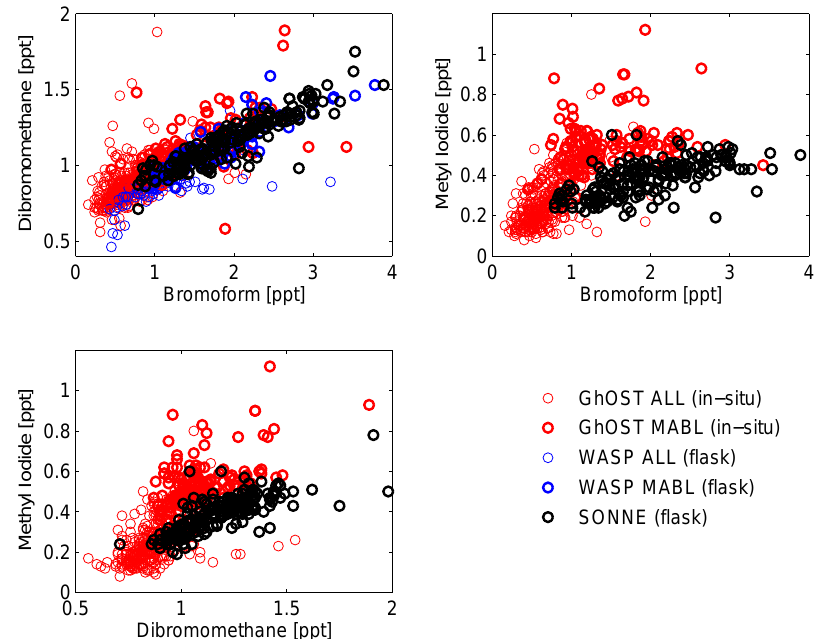
Figure 6. Correlation of bromoform and CH 2 Br 2 (upper left), bromoform and CH 3 I (upper right), and CH 2 Br 2 and CH 3 I (lower left) from GhOST and WASP for all heights (ALL) and only within the MABL (MABL) and from R/V Sonne .